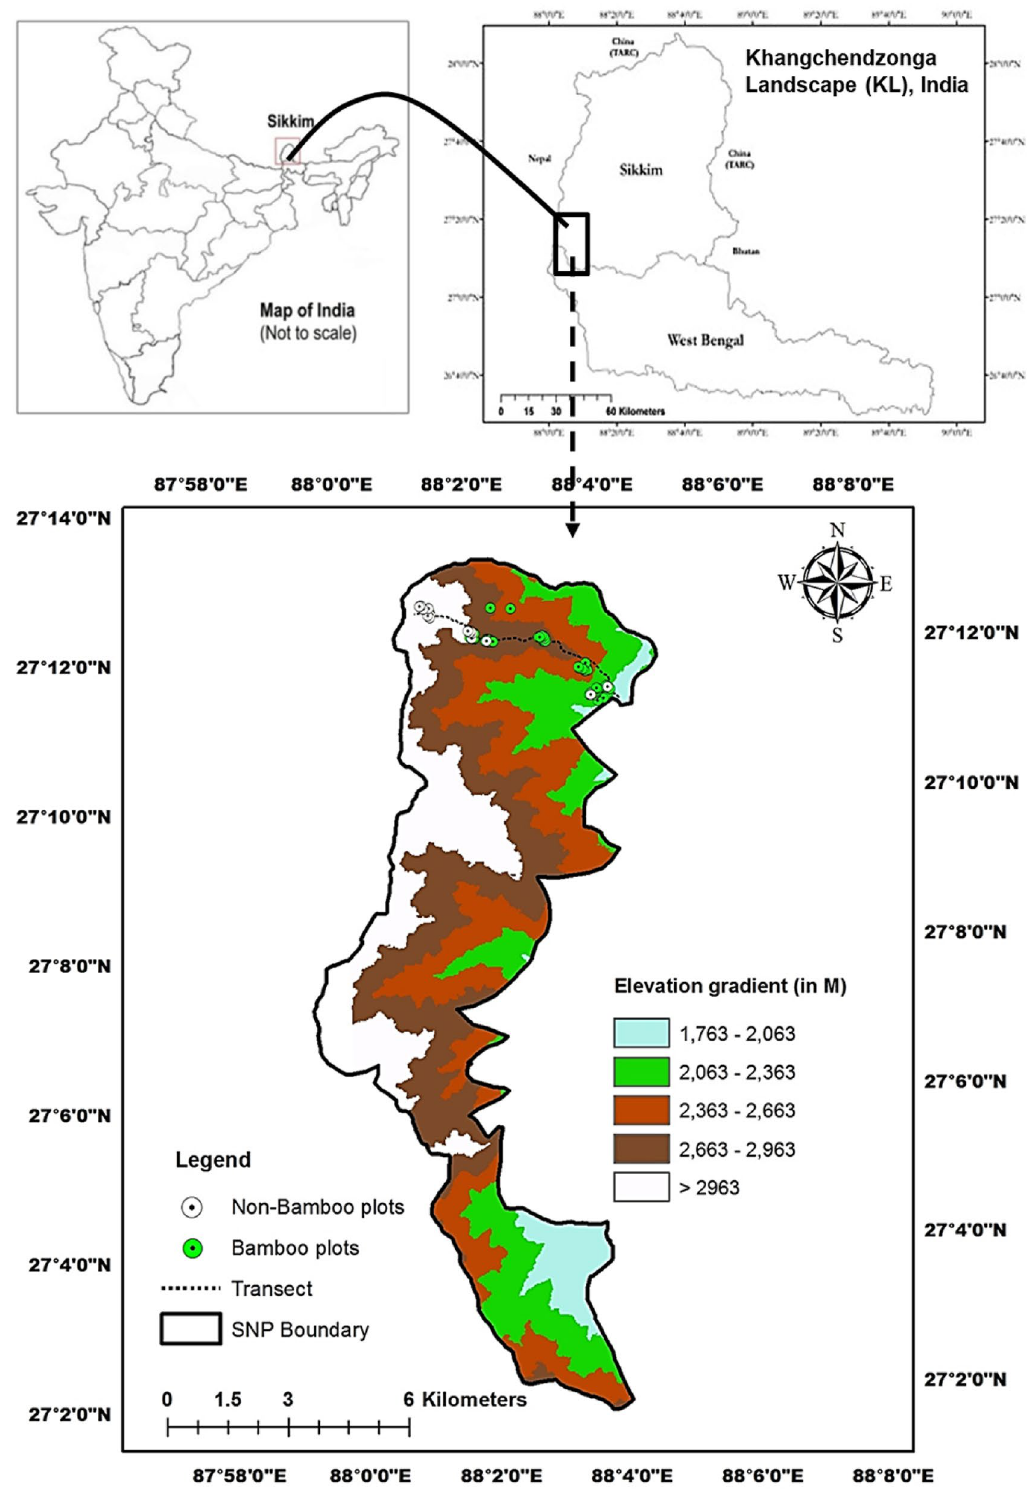
Figure 5. Study transect and location map of Singalila National Park under Khagchendzonga Landscape–India. The map was generated using the software Arc GIS version